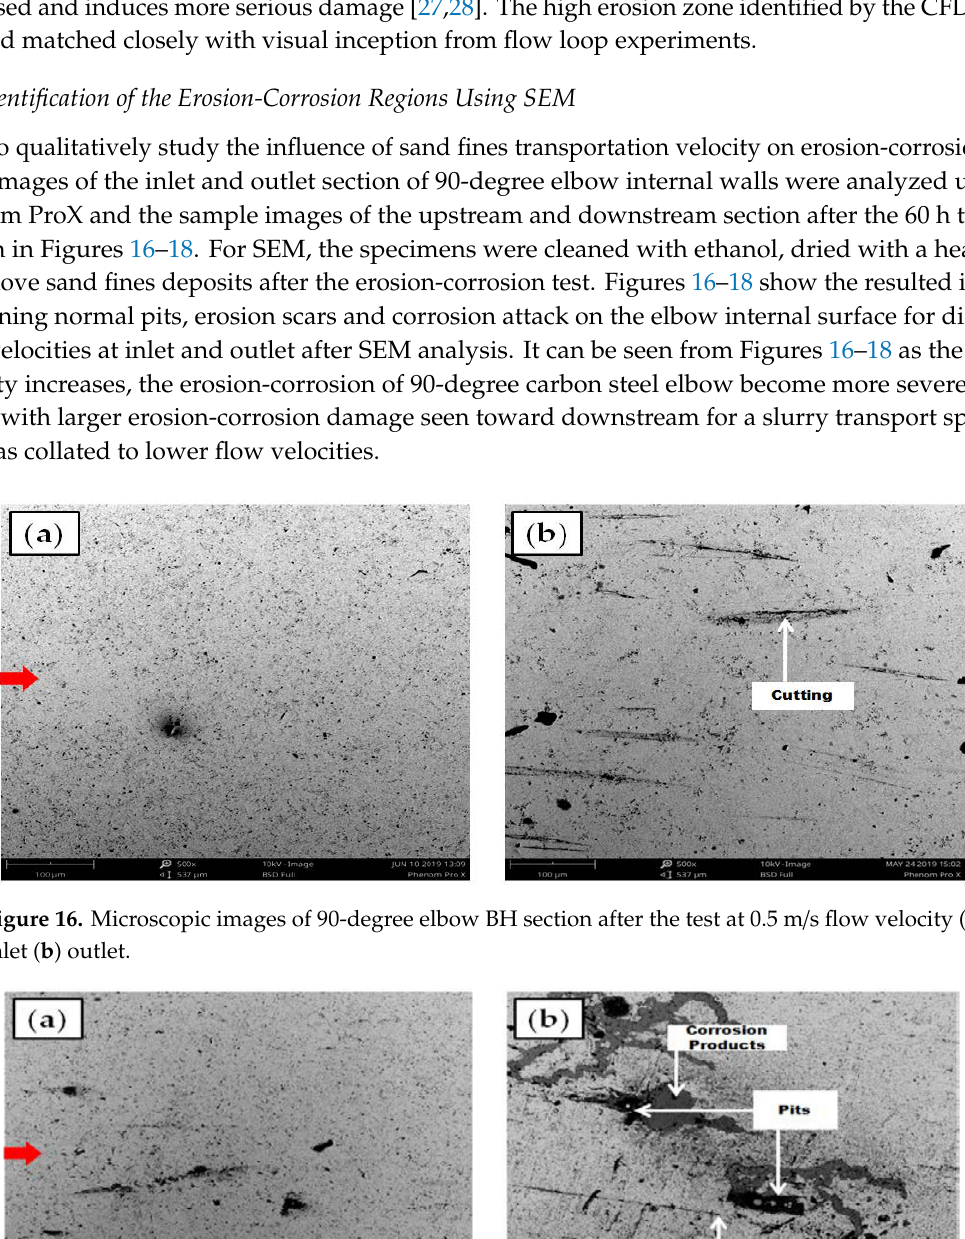
Figure 18. Microscopic images of 90-degree elbow BH section after the test at 2 m/s flow velocity ( a ) inlet ( b ) outlet. 4.4. Mass Loss After the erosion-corrosion with different flow velocities, the mass loss after 60 h test time in the BH and the UH section of the elbow is shown in Figure 19, respectively. In general, for high particle velocities, the kinetic energy and impact force of the particles are greater and result in more severe the erosion [30] but it can be seen from Figure 19 the mass loss of the BH and the UH section of the 90-degree elbow significantly increases with the escalation of slurry velocity at the same time and resulting in greater mass loss. The mass-loss rates differed for the BH and UH section of the elbow between 68 and 135 mg for the BH, between 5 and 11 mg for a UH section at a slurry speed of 0.5, 1 and 2 m/s as outlined in Figure 19. The mass loss of the elbow escalates with increasing flow velocity